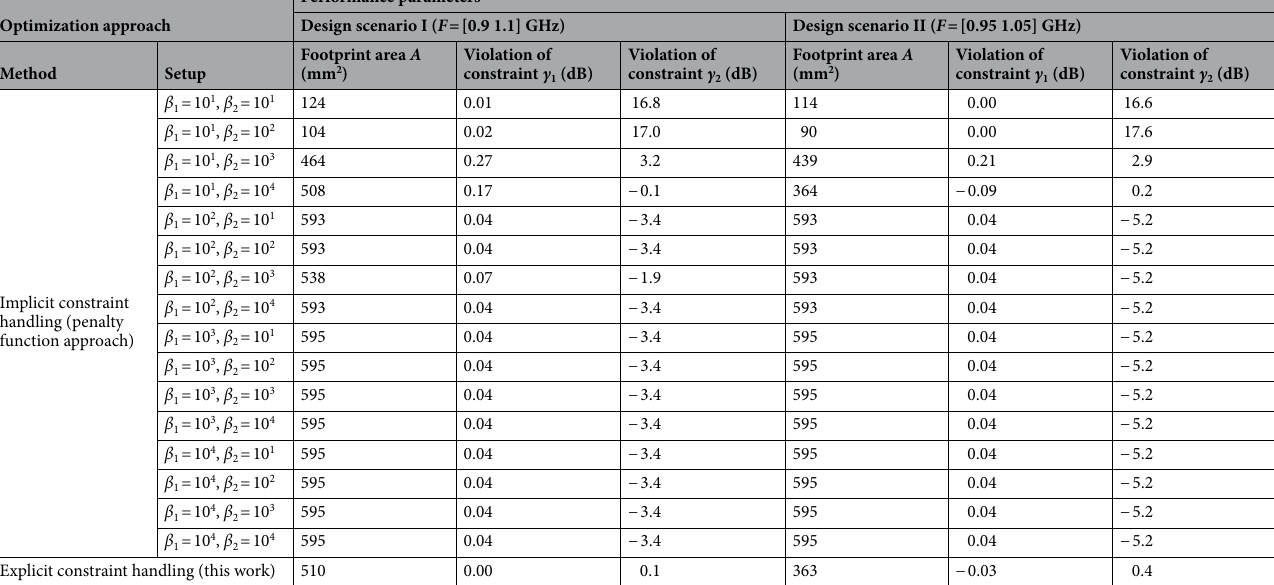
Table 3. Optimization results for Circuit